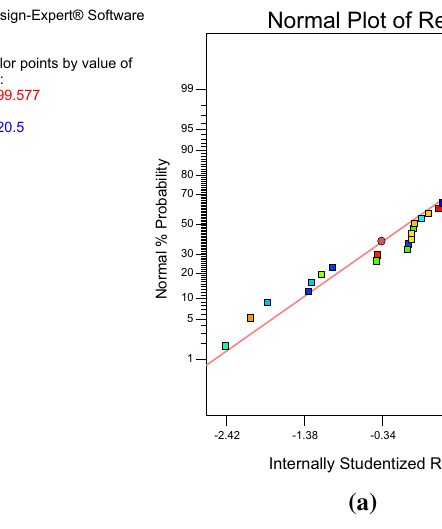
Fig. 11 a Plot of normal (%) probability versus residuals, b plot of predicted versus actual